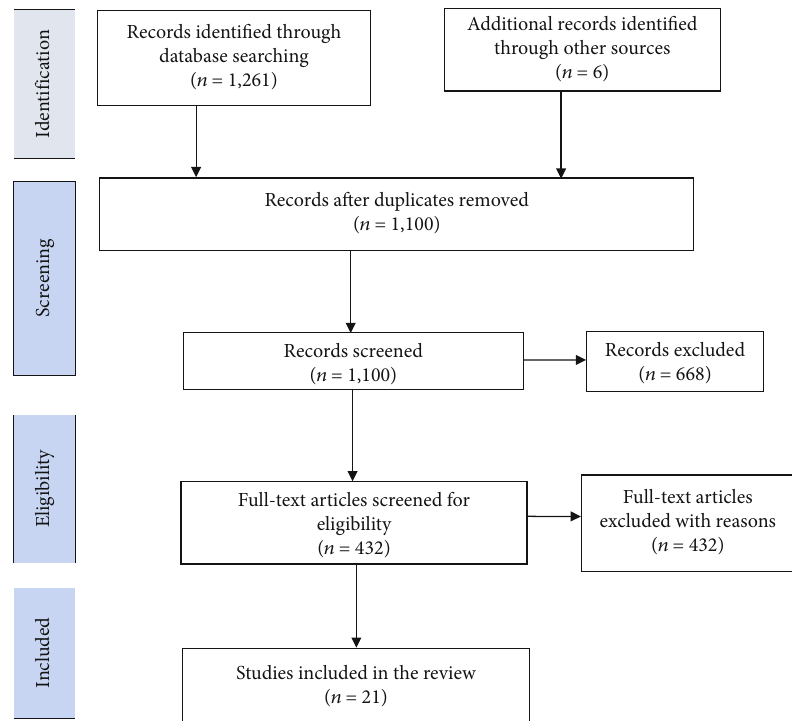
Figure 1: Literature search fl ow